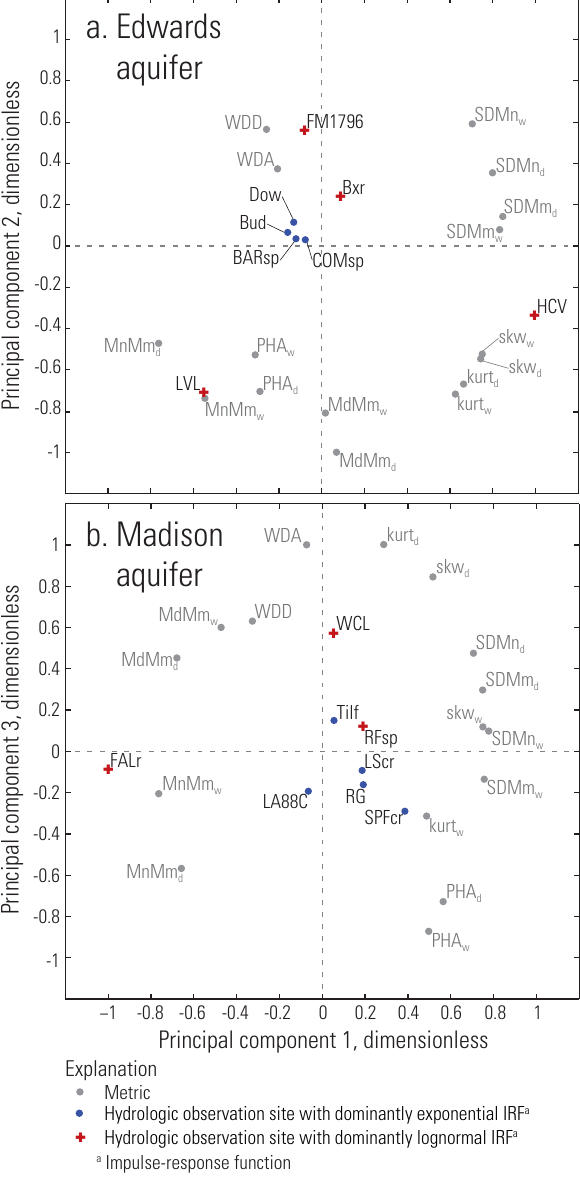
Fig. 5. Principal component biplots showing simulated sites and metrics for the first two principal components for the (a) Edwards aquifer and (b) Madison aquifer. Plotting positions were scaled to range from − 1 to 1 to show sites and metrics on a similar scale. Site and metric labels are shown in Tables 2 and 3.